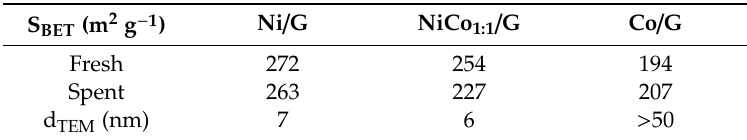
Table 3. Comparison of the surface area measure for the fresh and spent catalysts and average particle size of the spent catalysts obtained by TEM.